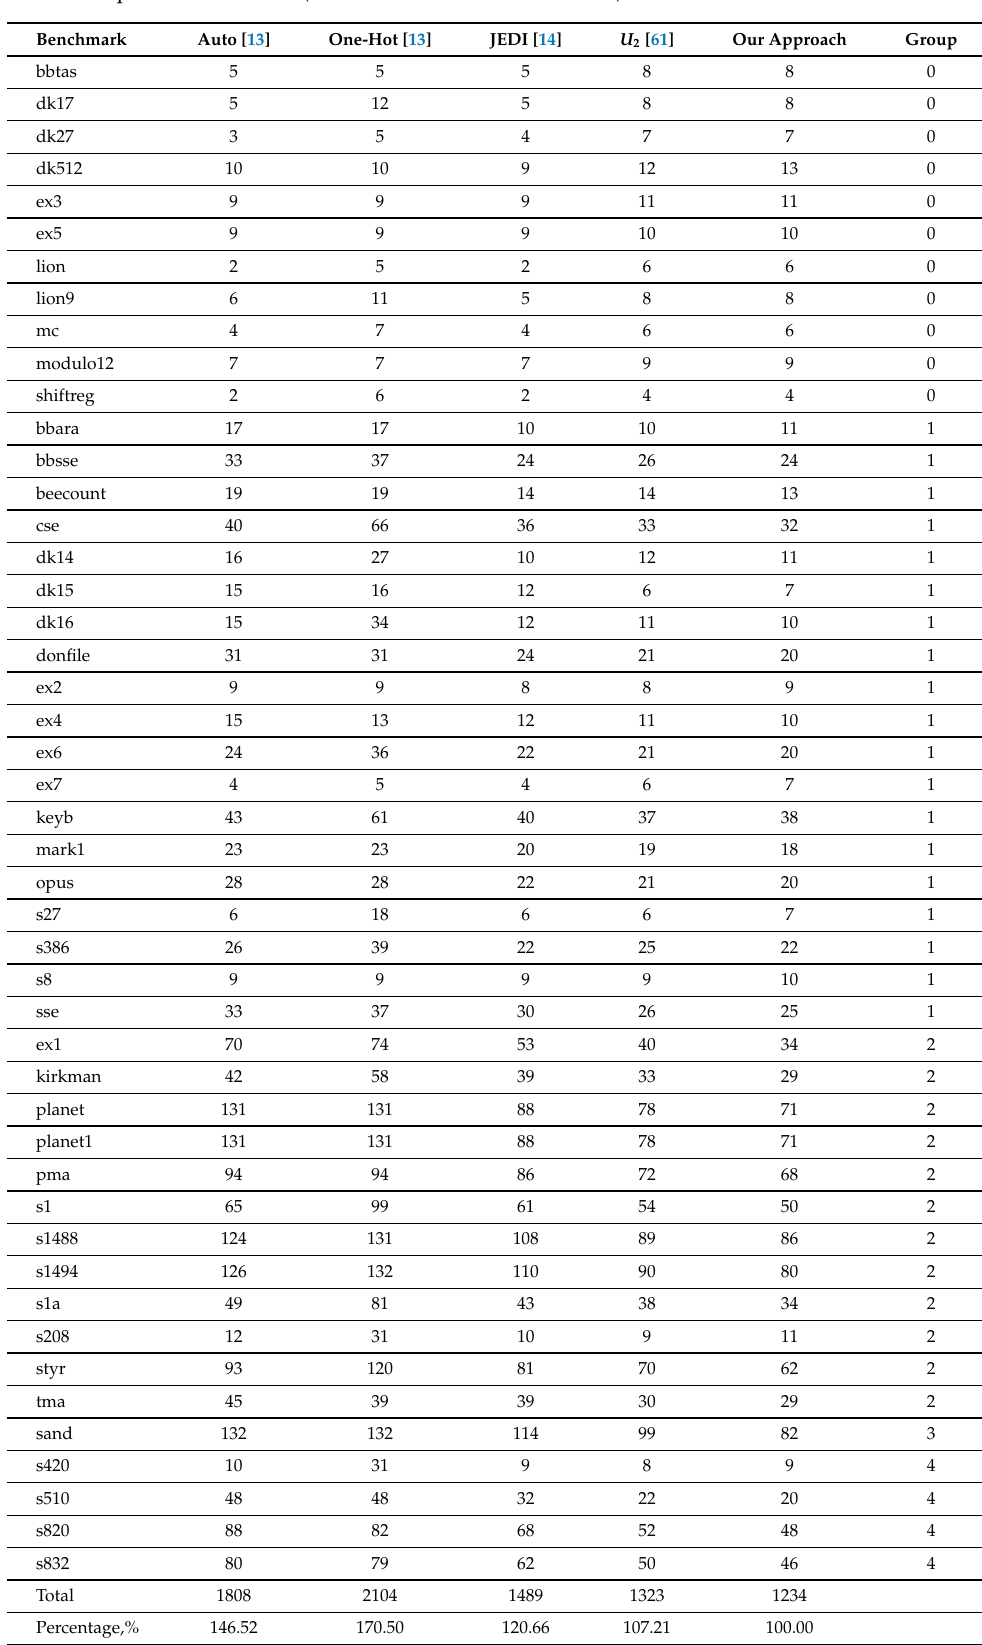
Table 8. Experimental results (LUT counts for all